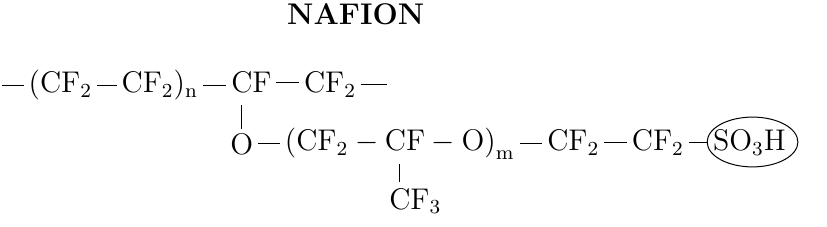
H tipped side chains, is the industry 3